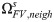
Schematic diagrams of the derivation of the coupling condition between one of the arteriolar or venular endpoints and the continuum representing the capillary bed.(a) The legend shows all the domains used for the development of the coupling model with a detailed nomenclature provided in Appendix D. (b) An arteriolar or venular tree ΩAV (black network) plunges into a FV grid ΩFV (green grid). The capillary vessels in Ωcap that are connected to the coupling point (highlighted by a red dot) are represented in red. The coupling condition describes the relationship between the network pressure πs at this coupling point and the pressures of the surrounding cells ΩFV,neighs, which include the coupled cell. The pressure field is reconstructed in the local neighbourhoods Ωlins and Ωsphs using Eq 20a and 20b. In the most distant cells Ω¯sphs, the analytical approximation matches with the FV representation further away. To make visualizations easier, a centered coupling is illustrated. (c) Detailed view of the coupled cell. The linear and spherical approximations match at a distance lΓ from the coupling point. πΓ is the averaged weighted pressure evaluated at this distance. (d) 1D pressure profile: FV pressures (green steps) are plotted on the left-hand side while both linear (red) and spherical (blue) approximations are plotted on the right-hand side. (e) Domains for the computation of errors. Four regions have been selected to compare hybrid and CN approaches: the arteriolar and venular trees ΩAV (black), the coupling points s (red), the surrounding cells Ωsphs,ε (hatched blue) and the rest of the FV domain ΩFVε (hatched green) which excludes cells where the pressure field must be analytically reconstructed.